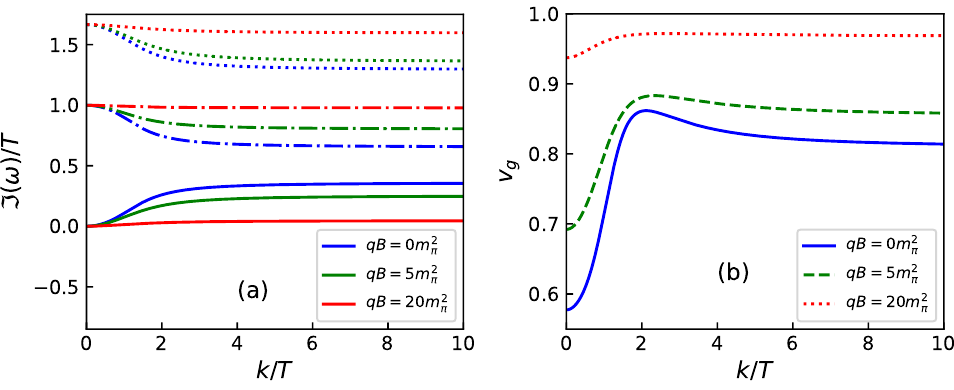
. v g is obtained from a 2